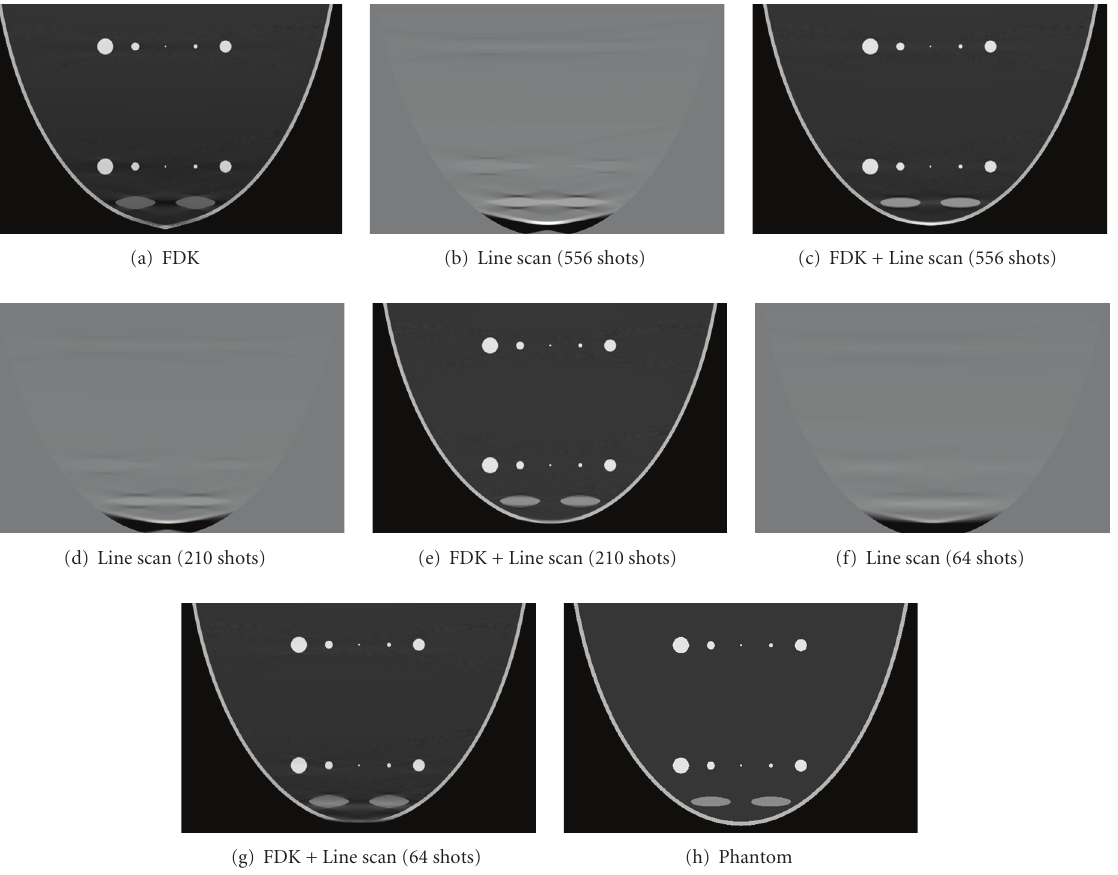
Figure 8: The central sagittal image comparison between phantom and CL scan scheme with di ff erent sampling intervals along straight line trajectory. (a) Circular FDK reconstruction; (b) straight line scan reconstruction (556 shots); (c) FDK + Line reconstruction (556 shots for line scan); (d) straight line scan reconstruction (210 shots); (e) FDK + Line reconstruction (210 shots for line scan); (f) straight line scan reconstruction (64 shots); (g) FDK + Line reconstruction (64 shots for line scan); (h) phantom image of the same sagittal slice.